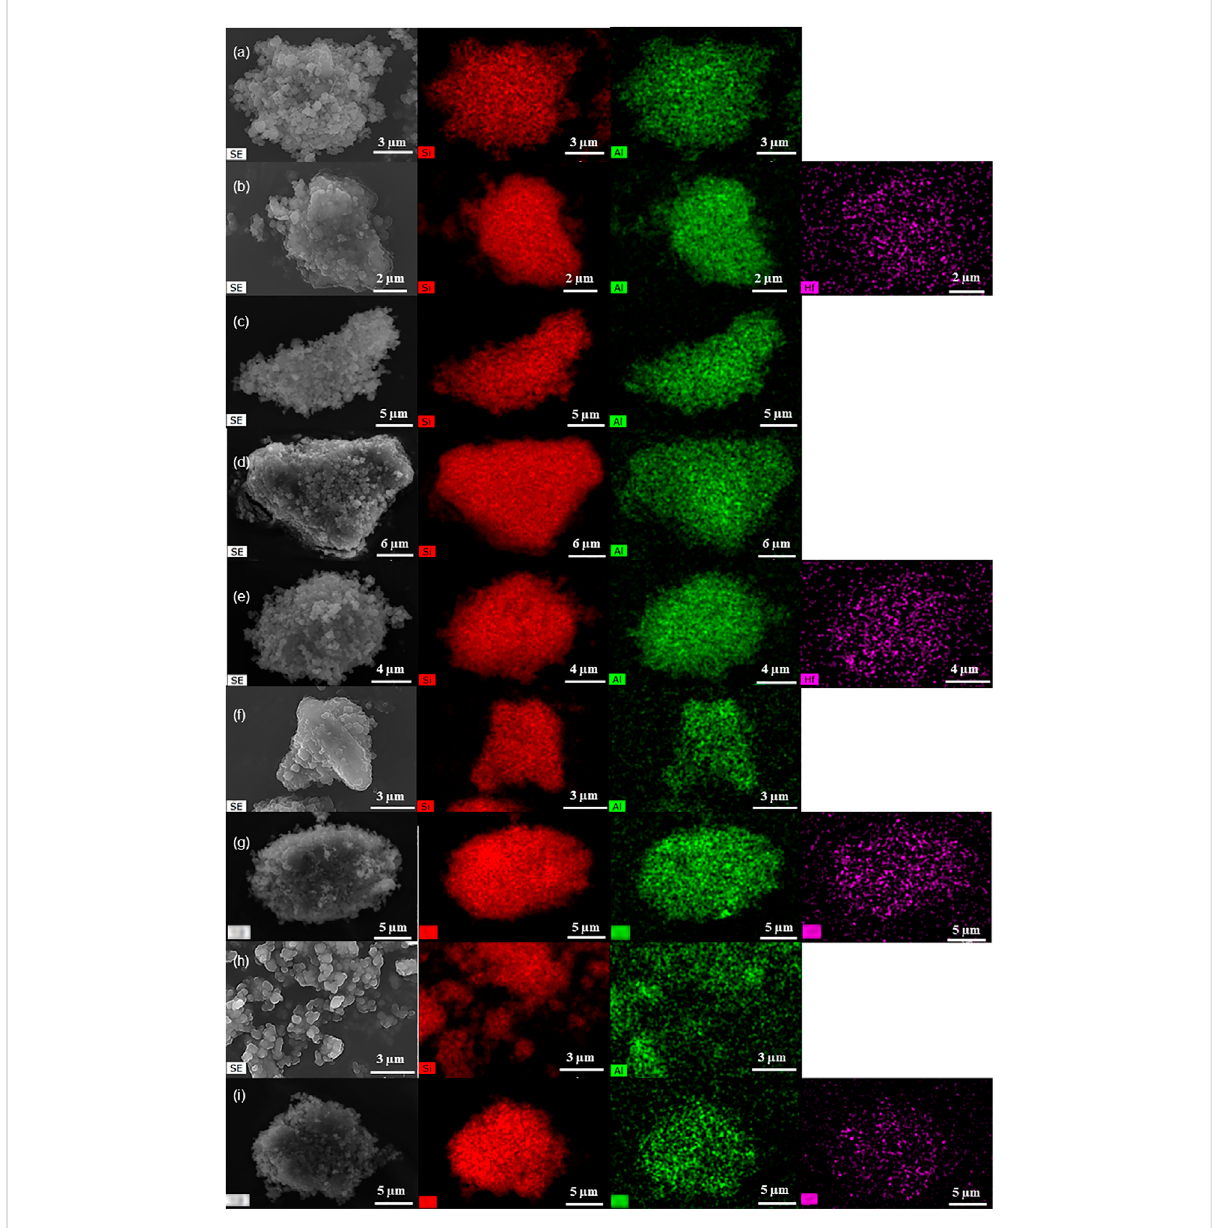
FIGURE 3 SEMimages(left)and element mappings(Si – red,Al – green,Hf – purple)ofKL(a),5Hf-HL(b),D-KL (c),D-HL(x) (x= 0.15(d), 0.20(f),0.28